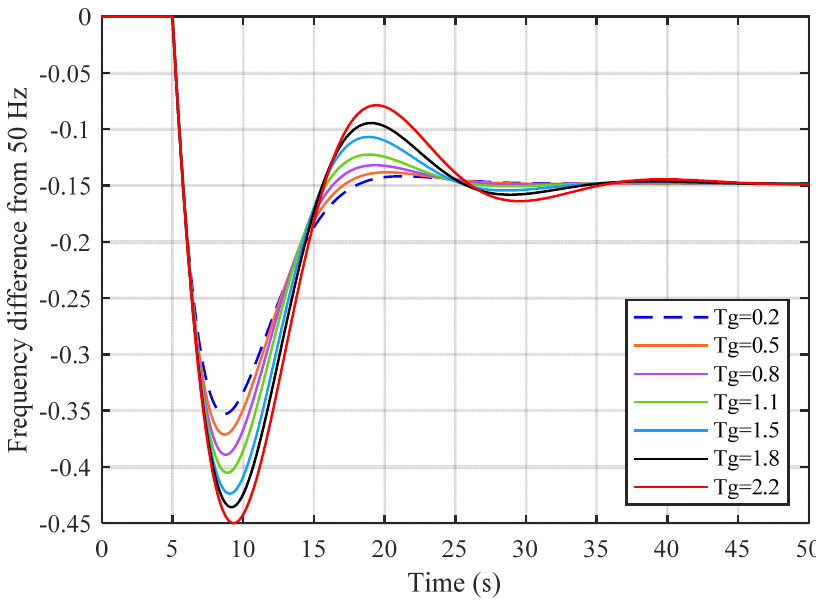
Figure A2. The primary frequency response of GB power system with various values of Tg.